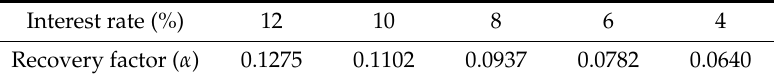
Table 1. Capital Recovery Factor calculation.